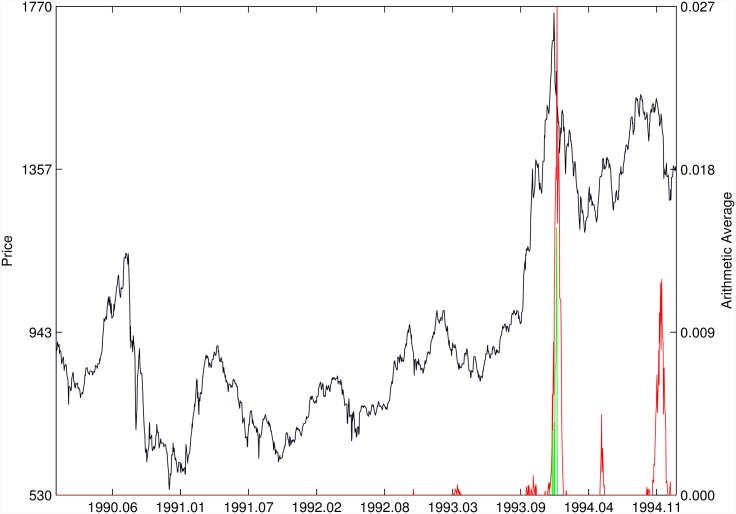
Thailand 1994.Same as Fig 10.